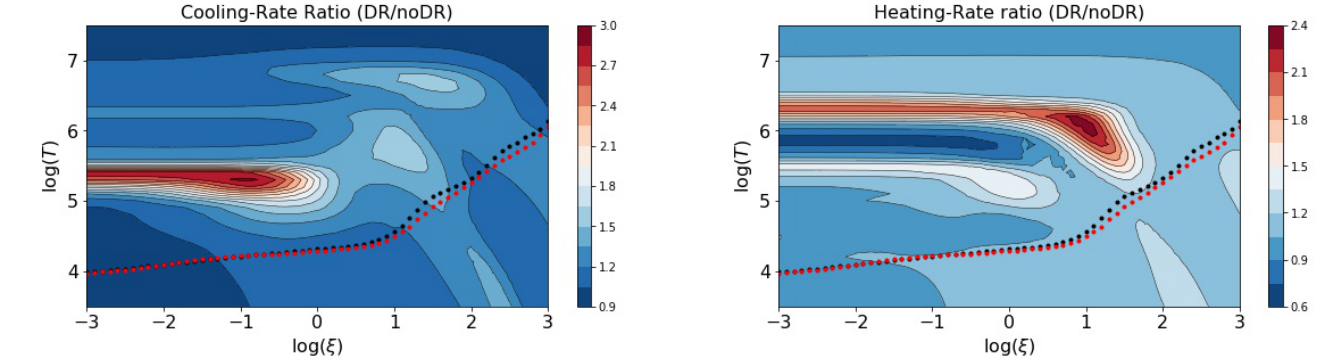
Figure 9. Cooling- and heating-rate ratios with and without DR obtained from an XSTAR model with solar abundances, a power-law spectrum, density n e = 10 10 cm − 3 , and luminosity L = 10 32 ergs − 1 . Black dotted curve: thermal temperature with DR. Red dotted curve: thermal temperature without DR.